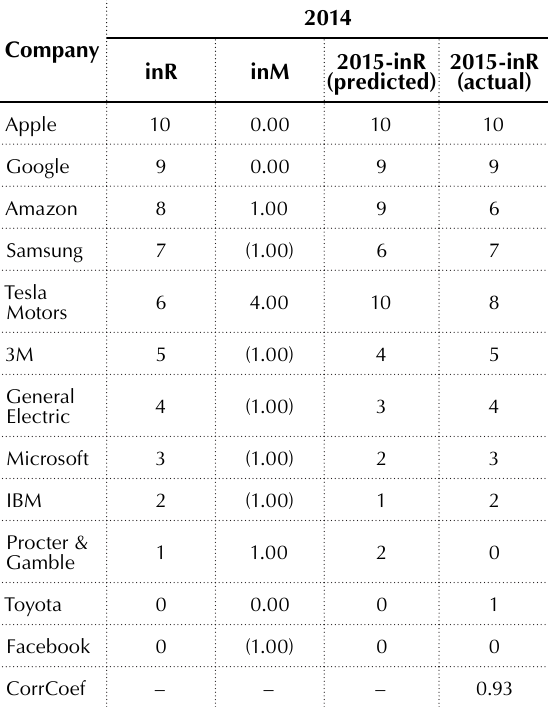
Table 5 makes several notable predictions, name- ly that several of the Constant Bottom Innovators, namely GE, IBM, P&G and Toyota will totally drop out of the top 10 list or will at best be at the very bottom of the list if no new entrant threat- ens them. On the other end of the spectrum, the model also predicts that both 3M and Facebook will rise to the top with 3M vying for the top spot, and Facebook coming just below Google. Finally, the model also predicts that Tesla will maintain its high rank, while Amazon will reverse its decline of 2016 and threaten Tesla for the rank of 6